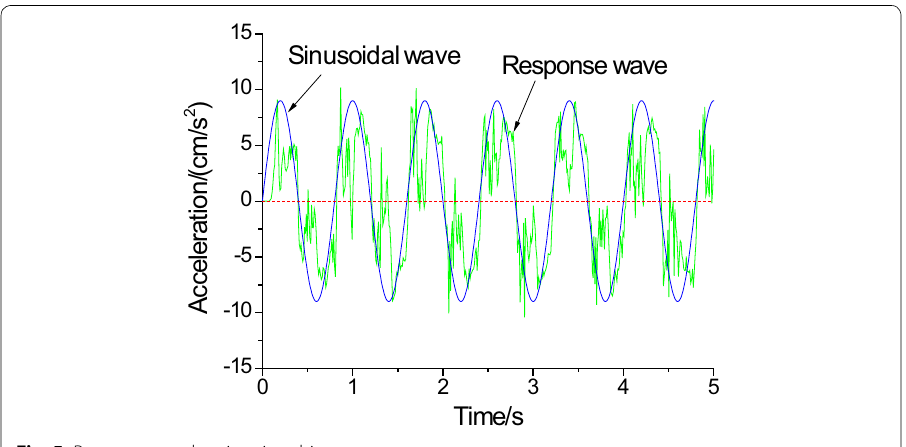
Fig. 5 Response acceleration